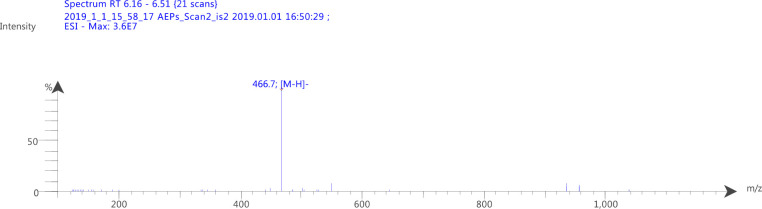
MS data for Phthal01.